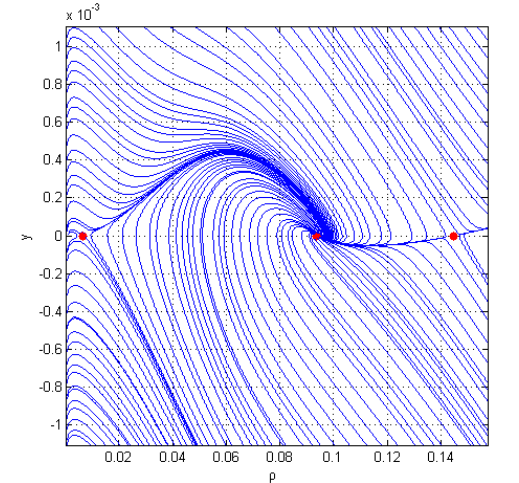
Fig. 1. Phase plane y-  trajectory diagram, where traveling wave velocity 371.1  c ,traveling wave parameter 2.0q * 